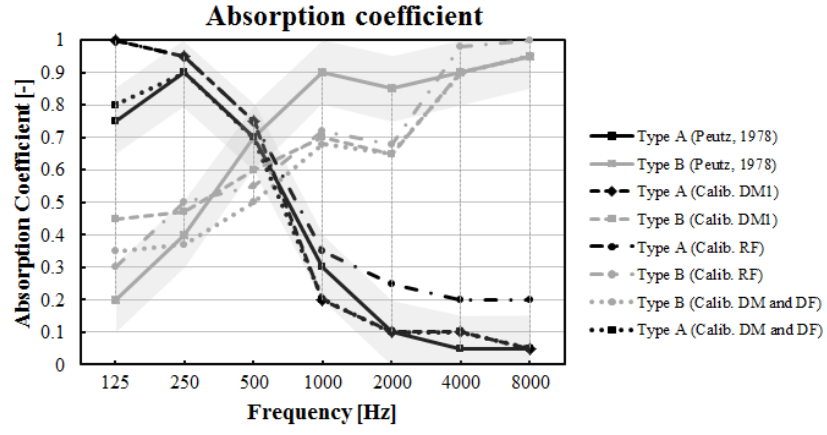
Figure 5. Calibration of the absorption coefficients of type A and type B materials. The gray area shows the lower and upper limit of the acceptable tolerances, as described in the materials’ properties in [37].